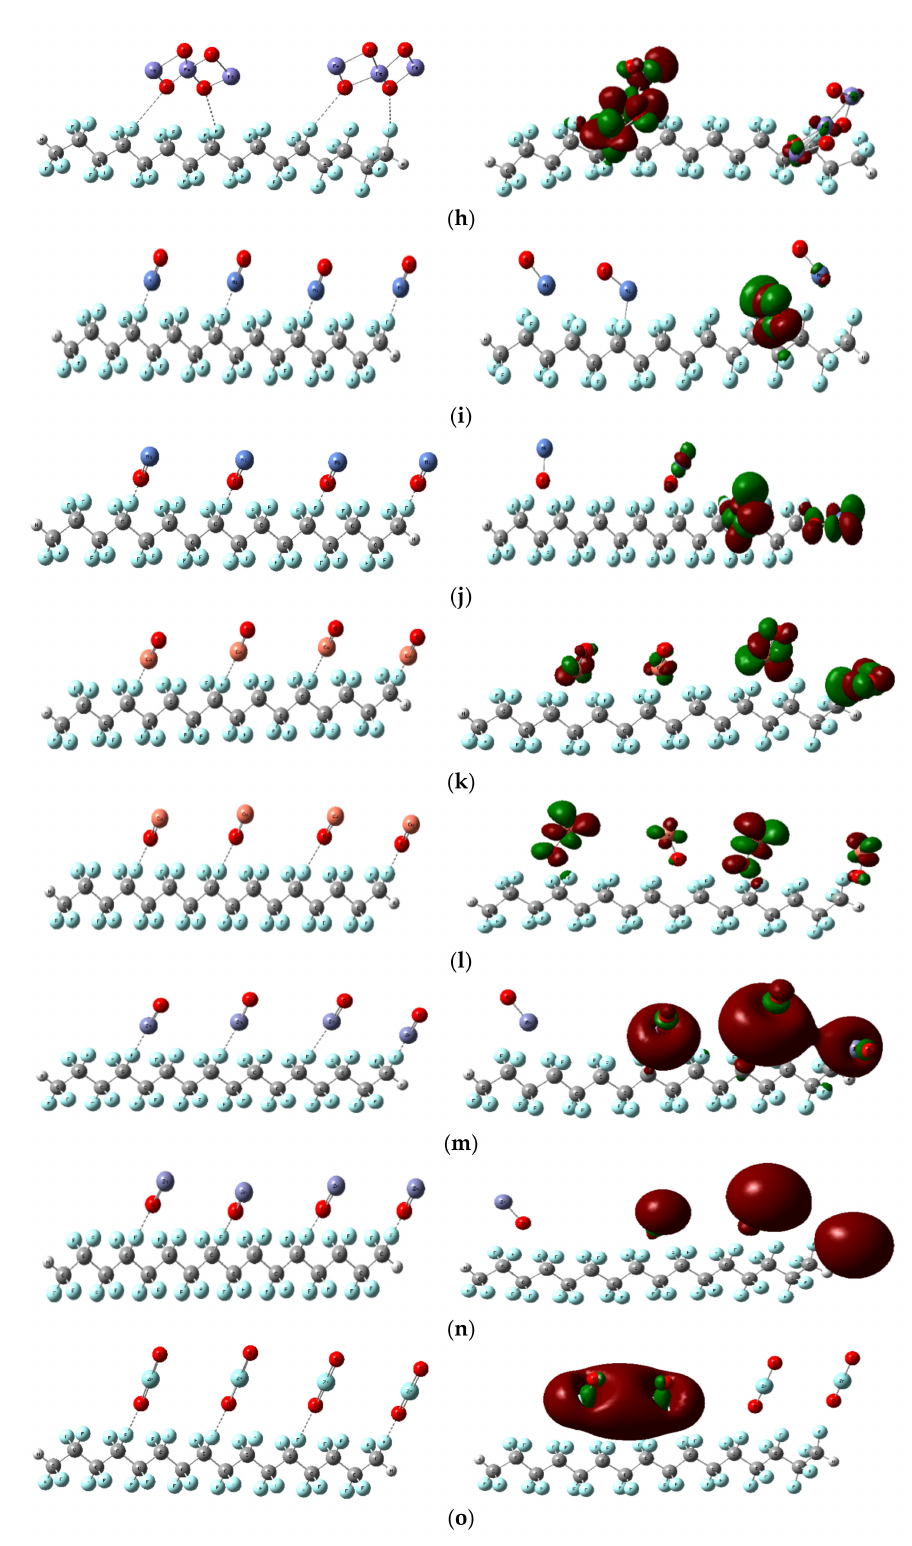
Figure 5. Optimized structure and HOMO/LUMO orbital distribution of PTFE interacting with differ- ent MOs using DFT:B3LYP/LANL2DZ as ( a ) PTFE, ( b ) PTFE/MgO, ( c ) PTFE/Omg, ( d ) PTFE/Al 2 O 3 , ( e ) PTFE/O 3 Al 2 , ( f ) PTFE/SiO 2 , ( g ) PTFE/TiO 2 , ( h ) PTFE/Fe 3 O 4 , ( i ) PTFE/NiO, ( j ) PTFE/ONi, ( k ) PTFE/CuO, ( l ) PTFE/OCu, ( m ) PTFE/ZnO, ( n ) PTFE/OZn, ( o ) PTFE/ZrO 2